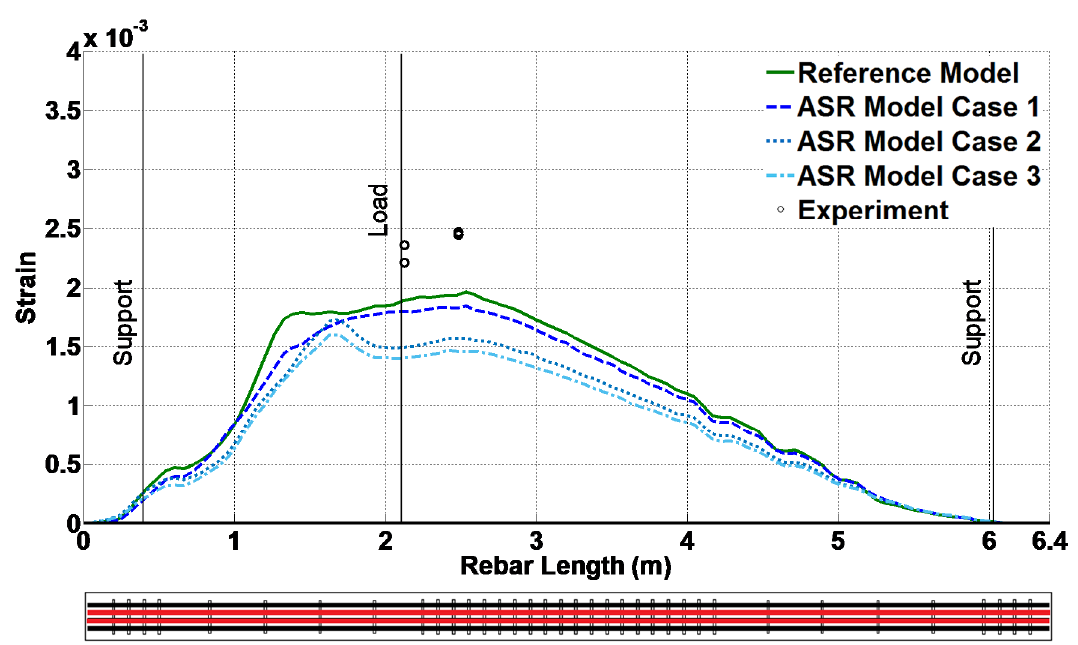
Figure 17. Strain along the length of the bottom longitudinal rebar at peak load.